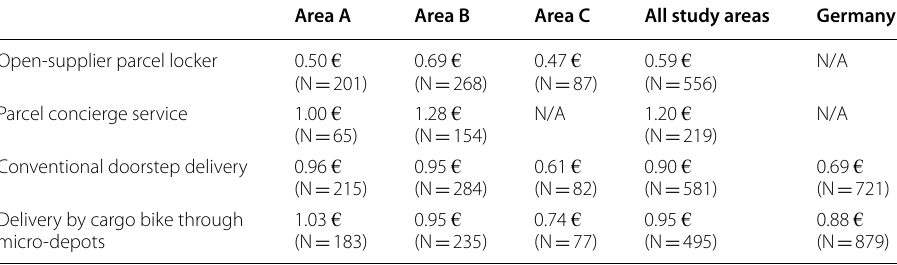
Area A Area B Area